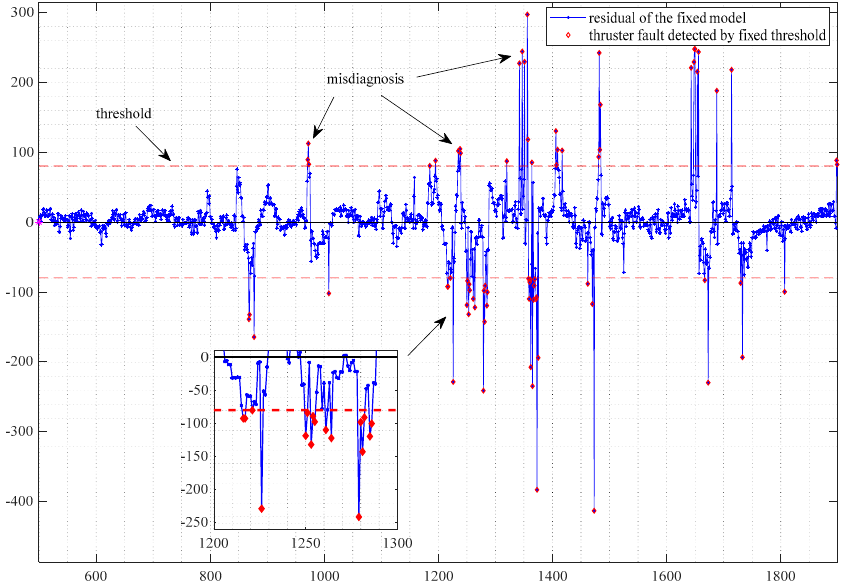
Figure 10. Model residuals of the fixed model-based fault detection method during sea trial of the HOV.